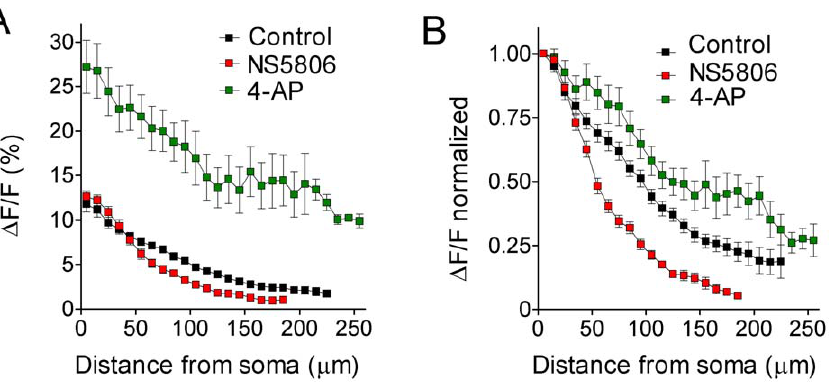
Figure 8. Analysis of pharmacological modulation of b-AP-related Ca 2 + signal dynamics. A . Maximal fluorescence changes ( D F/F in %) along the apical dendrite (10 m m steps, starting 5 m m from the soma) under control conditions (black; n=36 continuous data sets averaged), in the presence of NS5806 (red; n=15 continuous data sets averaged) and in the presence of 4-AP (green; n=15 continuous data sets averaged). B . B-AP imaging data normalized to the signal next to the soma for control (black, n=36), NS5806 (red, n=15) and 4-AP (green, n=15). Note that the attenuation of the b-AP-induced Ca 2 + signal was strengthened in the presence of NS5806 and weakened in the presence of 4-AP.